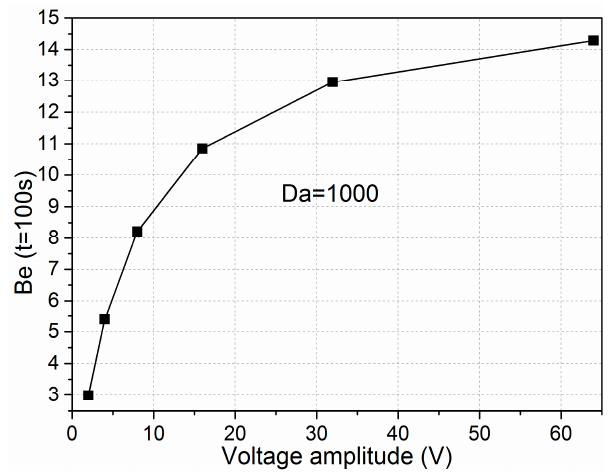
Figure 6. Binding enhancement factor with respect to sinusoidal signals with different voltage amplitude applied at t = 100 s when the Da = 1000.